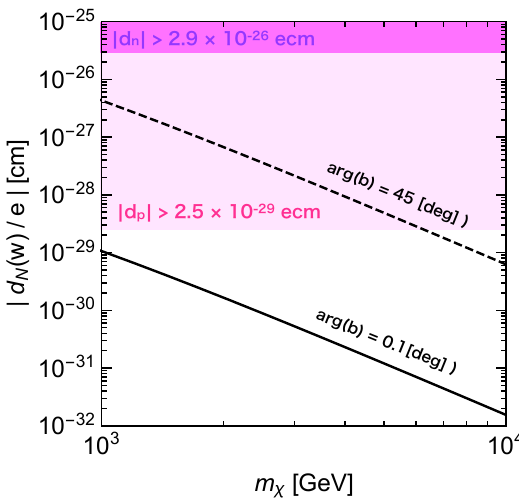
Figure 9 . Nucleon EDM induced by the CP-violating interactions between the DM and the mediator (cid:12)elds. We take the same parameter sets as in Model I-A in (cid:12)gure 2, with arg( b ) = 0 : 1 and 45 degrees in black solid and dashed lines, respectively. Dark and light magenta regions correspond to the current bound on the neutron EDM (